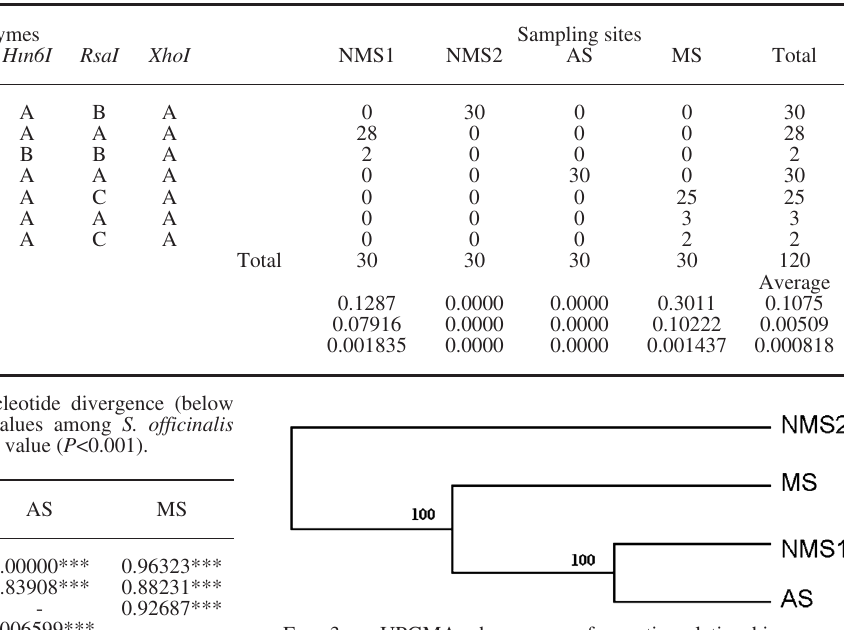
Fig. 3. – uPgma phenogram of genetic relationships among populations of S. officinalis . Bootstrap estimates (as a Table 4. – Parameters of the sudden expansion model and goodness-of-fit test to the model with respective significance for each population. S , number of polymorphic sites; θ , preexpansion 0 population size; θ , postexpansion population size; τ , time in number 1 of generations; SSD, sum of squared deviations; Hri; Harpening’s raggedness index; * Significant at P <0.05.